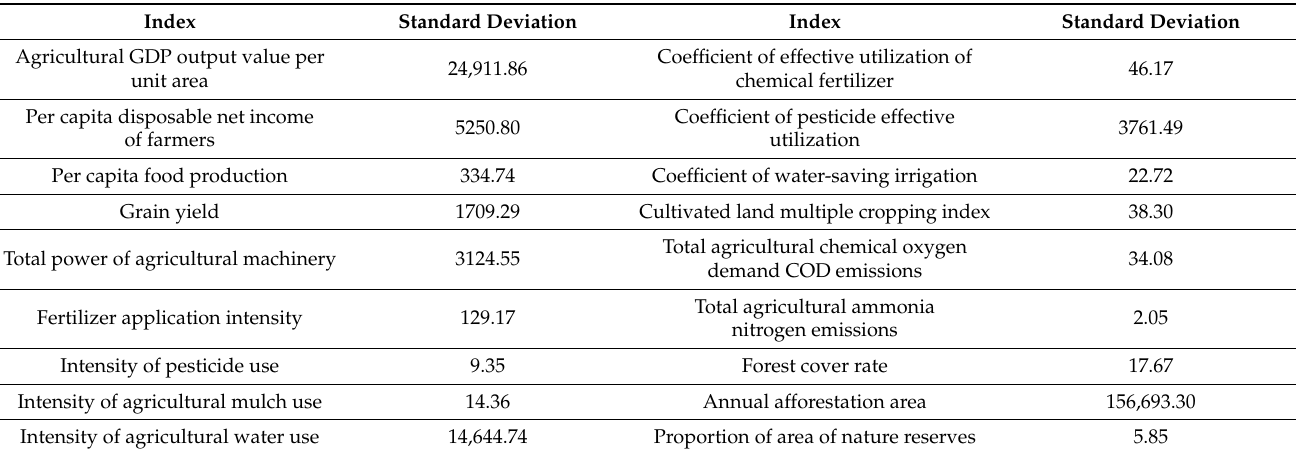
Table 2. Recognition degree